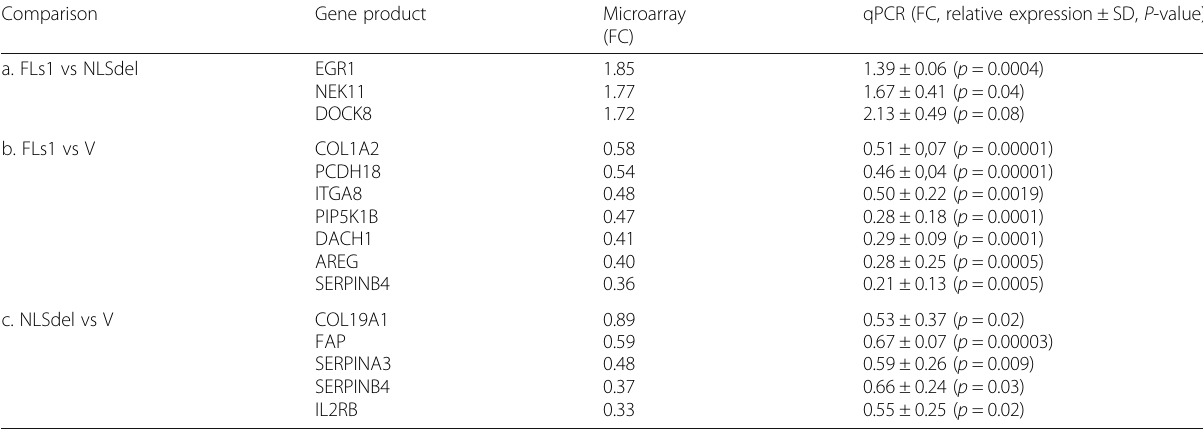
Table 2 Differentially expressed genes from Affymetrix array, validated by qRT-PCR